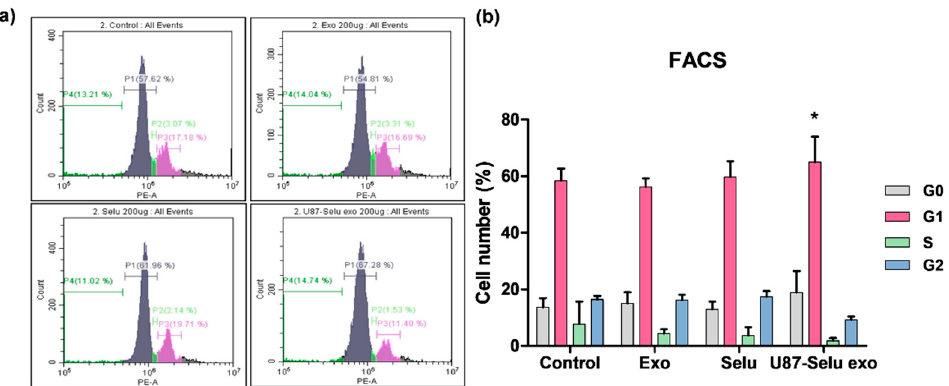
Figure 13. Cell cycle (G1 phase) arrest in U87-Selu exo as measured using flow cytometry. The harvested cells were subjected to PI staining and used for cell cycle analysis. ( a ) Cell cycle of each group; control, exo, Selu, and U87-Selu exo. ( b ) Number of cells in each phase. * p < 0.05 vs. non-treated control, n = 3.